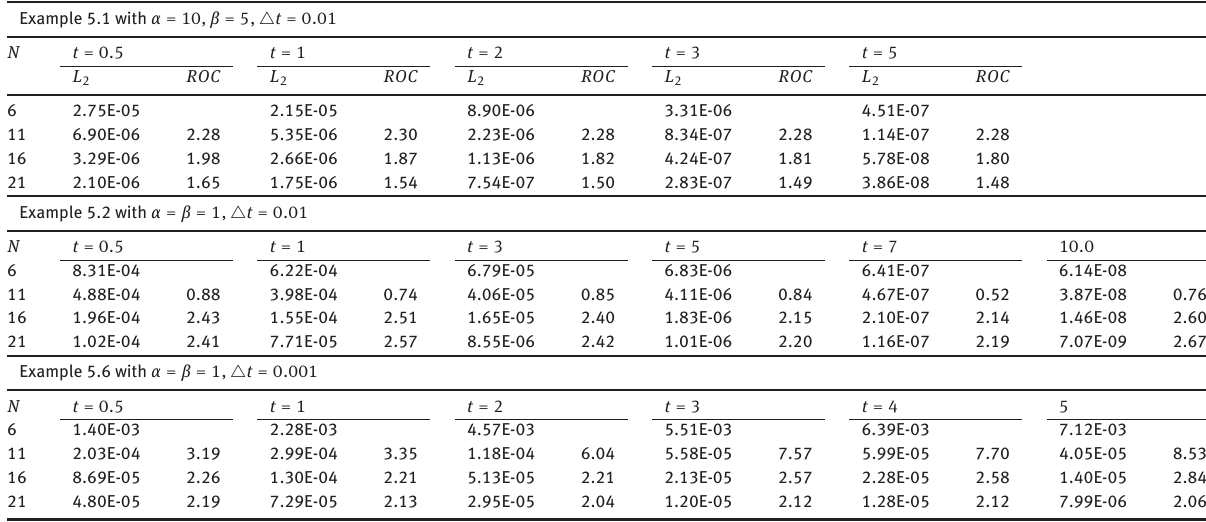
Table 1: Rate of convergence (ROC) for Example 5.1, Example 5.2 and Example 5.6 with N x = N y = N and p = 1 Example 5.1 with α = 10, β = 5, (cid:2) t = 0.01